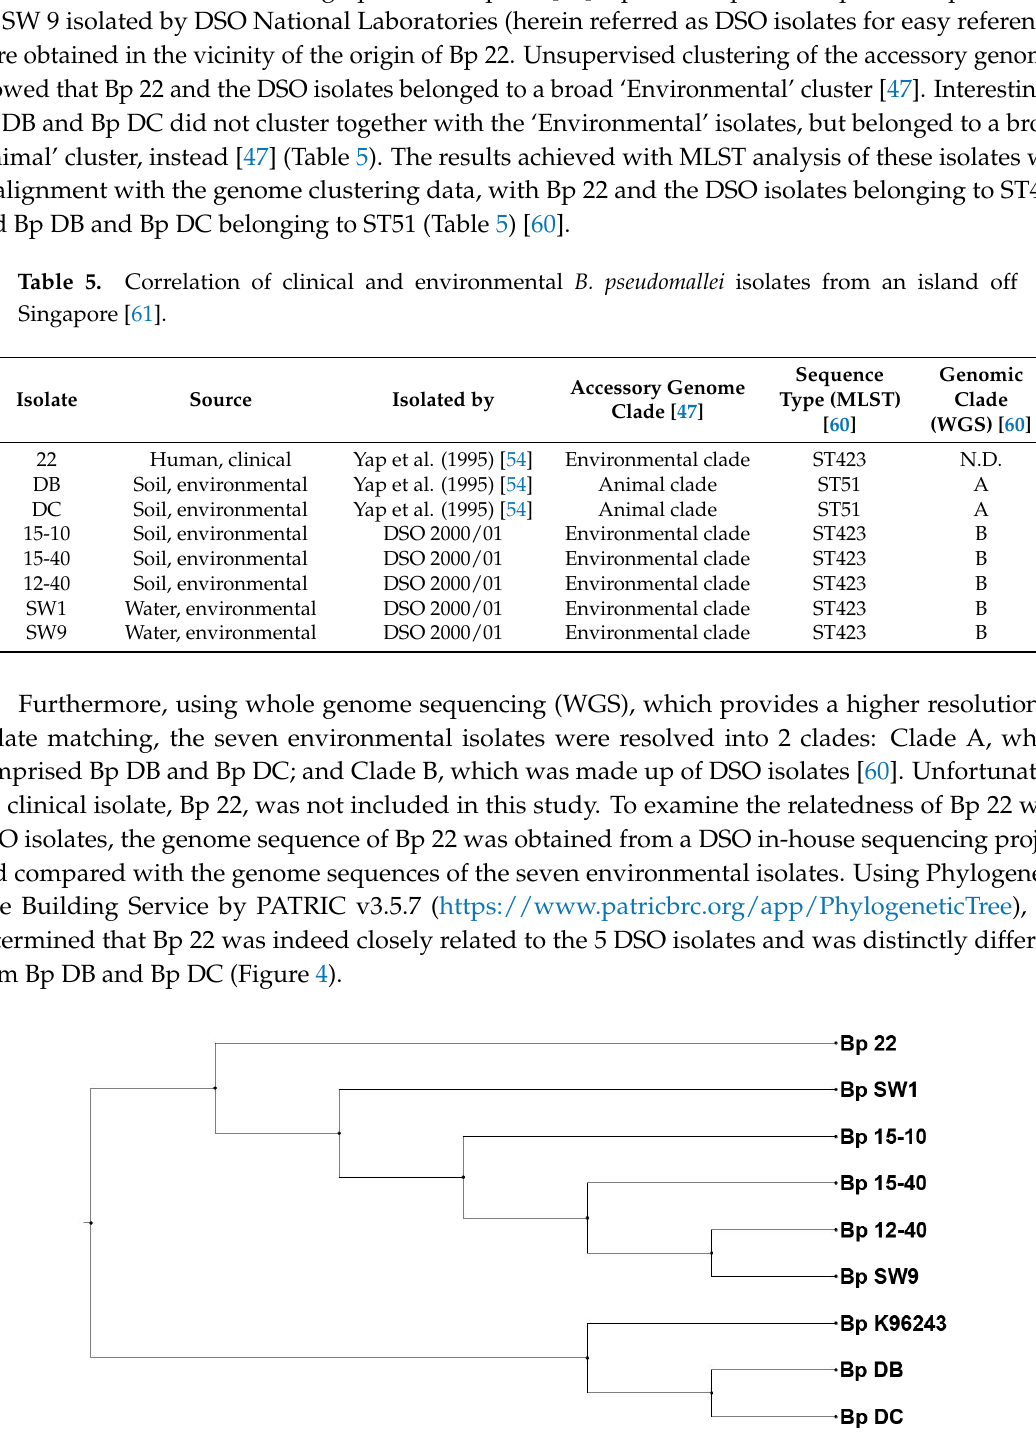
Figure 4. Whole genome phylogeny tree of clinical and environmental isolates from same locale in Singapore. Phylogenetic tree generated using Phylogenetic Tree Building Service by PATRIC v3.5.7 (https://www.patricbrc.org/app/PhylogeneticTree), depicting the relationships of the clinical isolate Bp22 and environmental isolates obtained from an island off Singapore. Bp K96243 was included as a reference